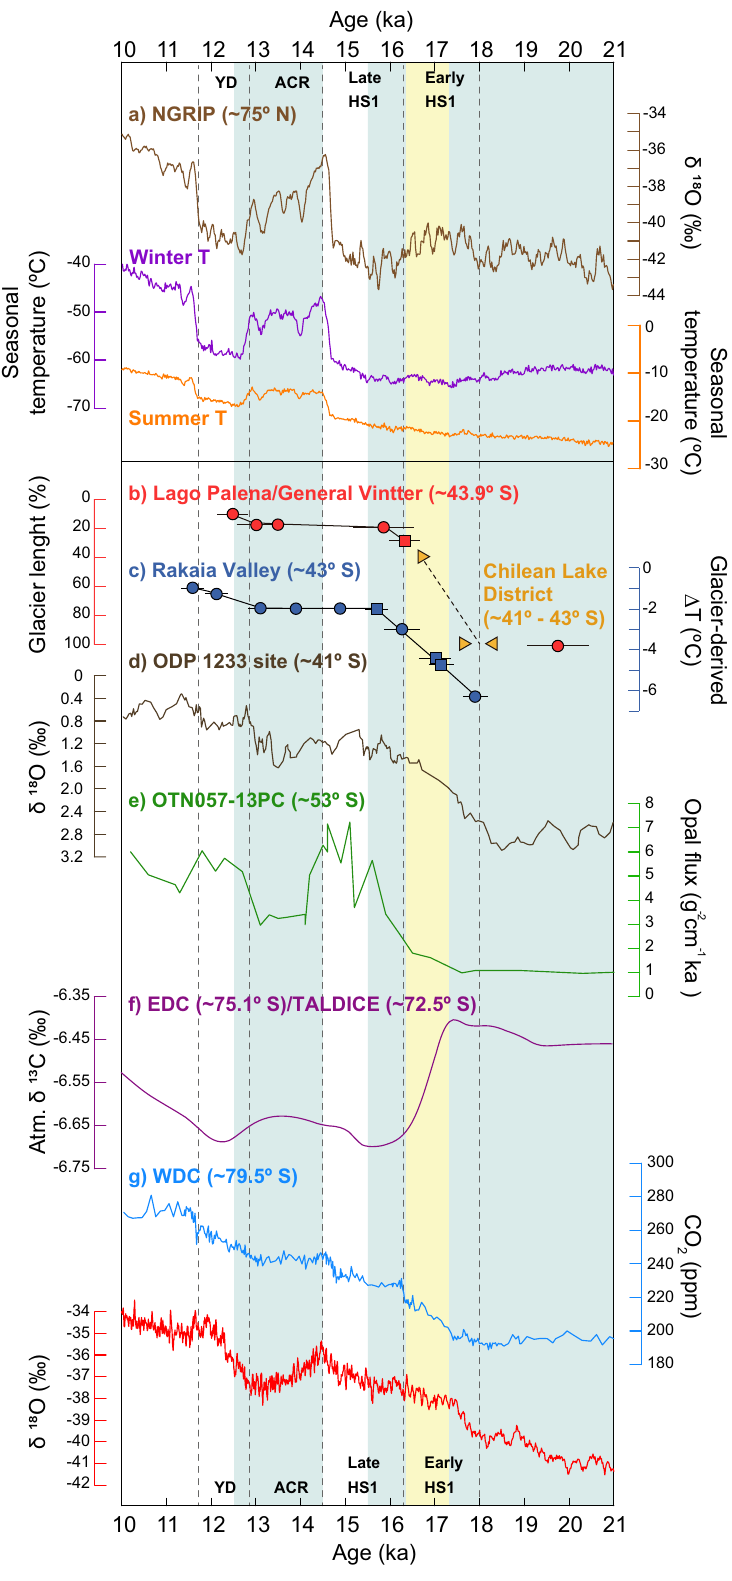
Figure 3. Paleoclimate proxies spanning T1. ( a ) Records from the North Greenland Ice Core Project (NGRIP): δ 18 O 3 ; winter temperatures in purple 57 ; summer temperatures in yellow 57 . ( b ) Glacier length of the Lago Palena/General Vintter ice lobe (this study). Yellow triangles are bracketing radiocarbon ages for the final glacial advance (100% length) of the LGM in the Chilean Lake District 14 . ( c ) Glacier-derived temperatures from Rakaia Valley, New Zealand 31,32 . ( d ) Planktonic δ 18 O from marine core ODP-1233 28 . ( e ) Opal flux from marine core TN057-13PC 9 . ( f ) Integrated δ 13 C from Talos Dome (TALDICE) and EPICA Dome C (EDC) 43 . ( g ) Records from the central West Antarctica Ice Core (WAIS): CO 2 in light blue and δ 18 O in red 42 . Blue bars highlight cold/wet intervals and yellow bars denote warm/dry periods inferred from palynological